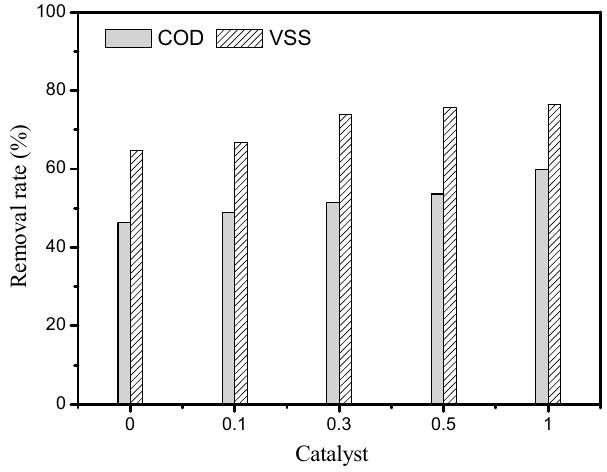
Figure 2. Effect of catalyst amount on the COD and VSS removal rates (Time: 60 min; Temp.: 220 °C; Oxygen dosage: 1.0 MPa).